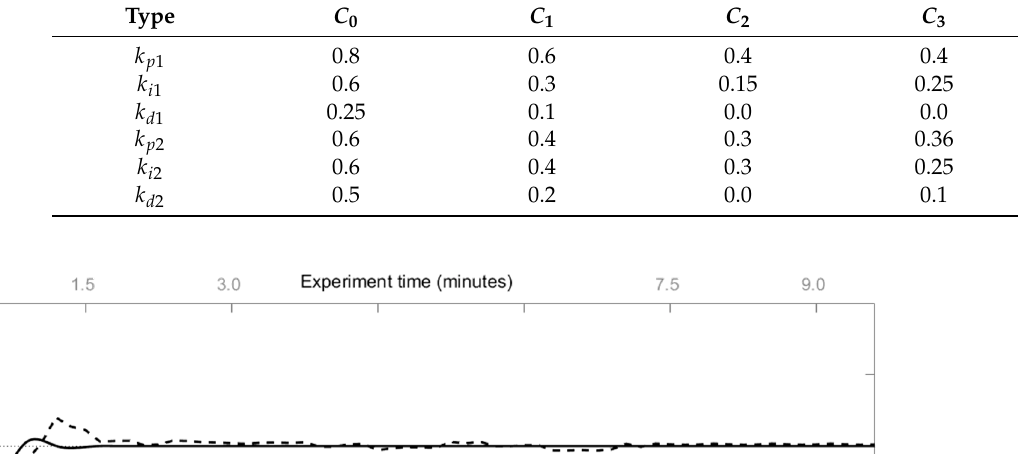
Table 5. Parameter controller gains C N for the system.